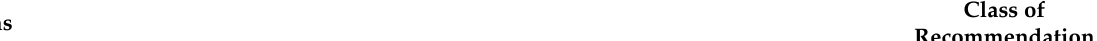
Table 1. Recommendations for transmission of the TTECG and cooperation between PCI centers and EMS